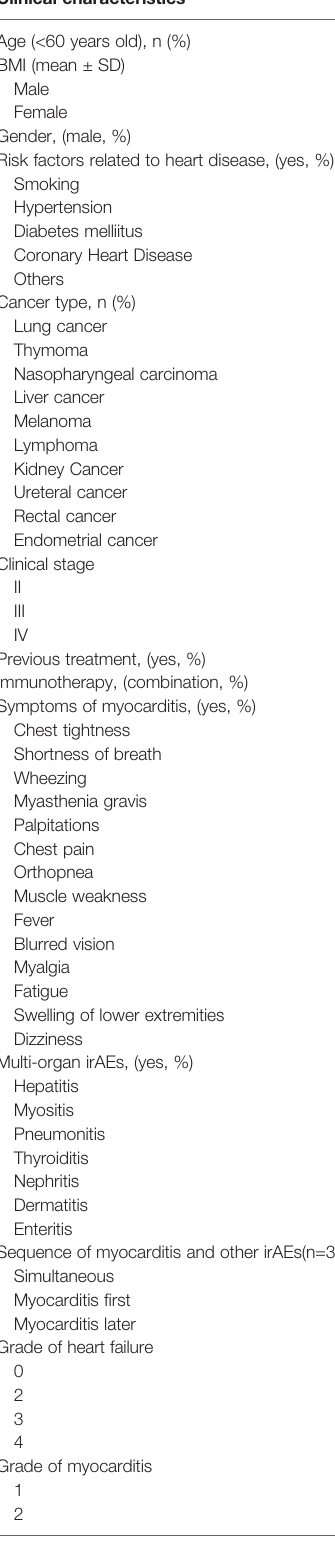
TABLE 1 | Clinical characteristics of all patients. Clinical